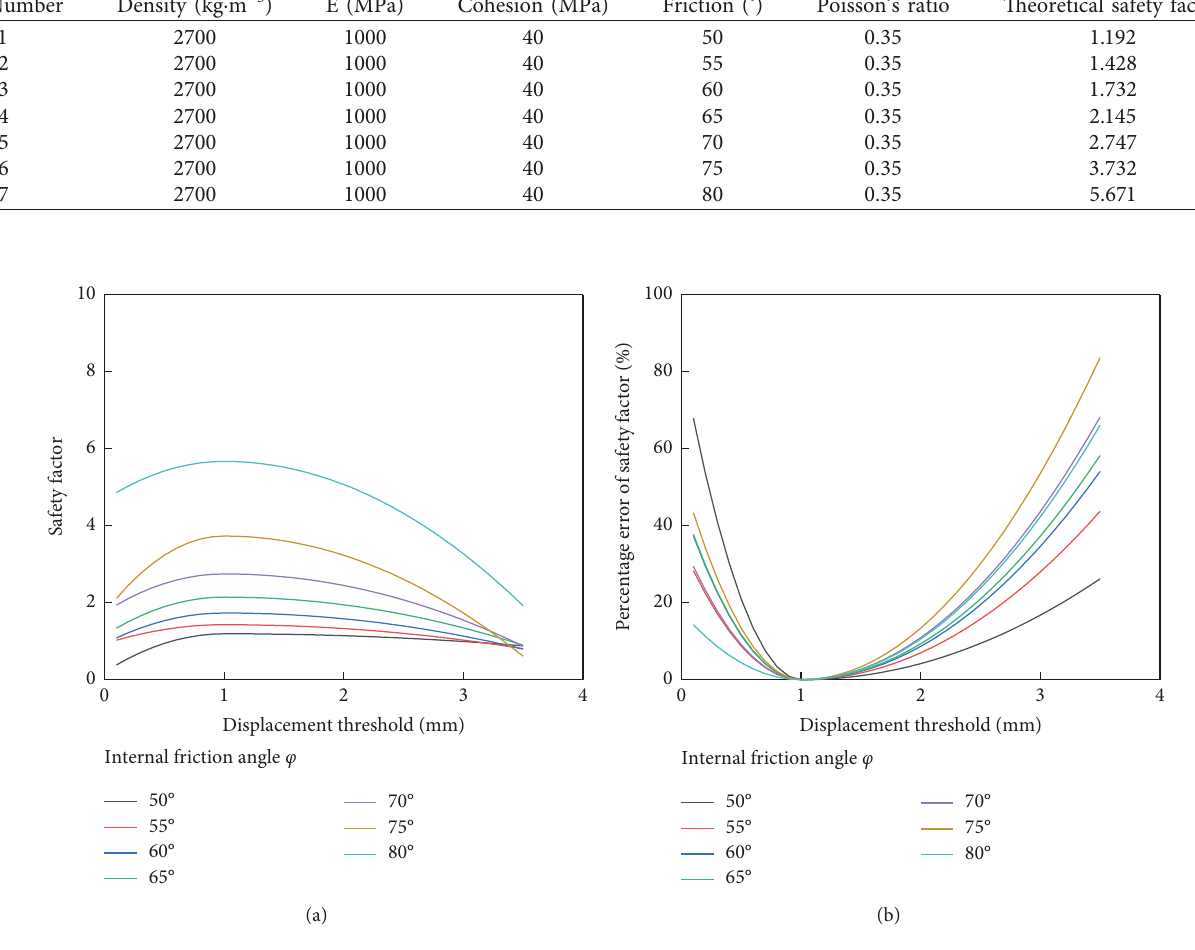
Figure 2: Curve of safety factor and its error with the displacement threshold: (a) safety factor; (b) percentage error of safety factor. Table 2: Contact status table. Contact